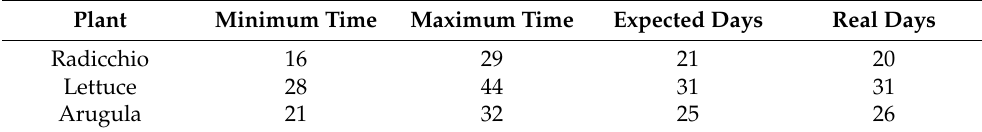
Table 3. Cultivation time for each